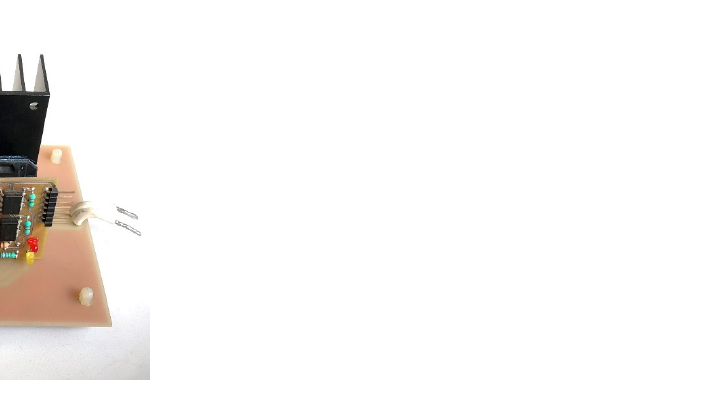
11 of 16 Figure 11. Oscillogram of the transient state of Z-source converter, during its operation change. 5.3. Multilevel Inverter Behavior in the Fault-Free Condition The CMLI design was implemented in the laboratory to verify its performance. The electrical parameters of the components used in the implementation are briefly described below: • Cells A, B, and C: Experimentally built with power modules IRAMS10UP60 (International Rectifier, El Segundo, CA, USA) (These power modules produce a